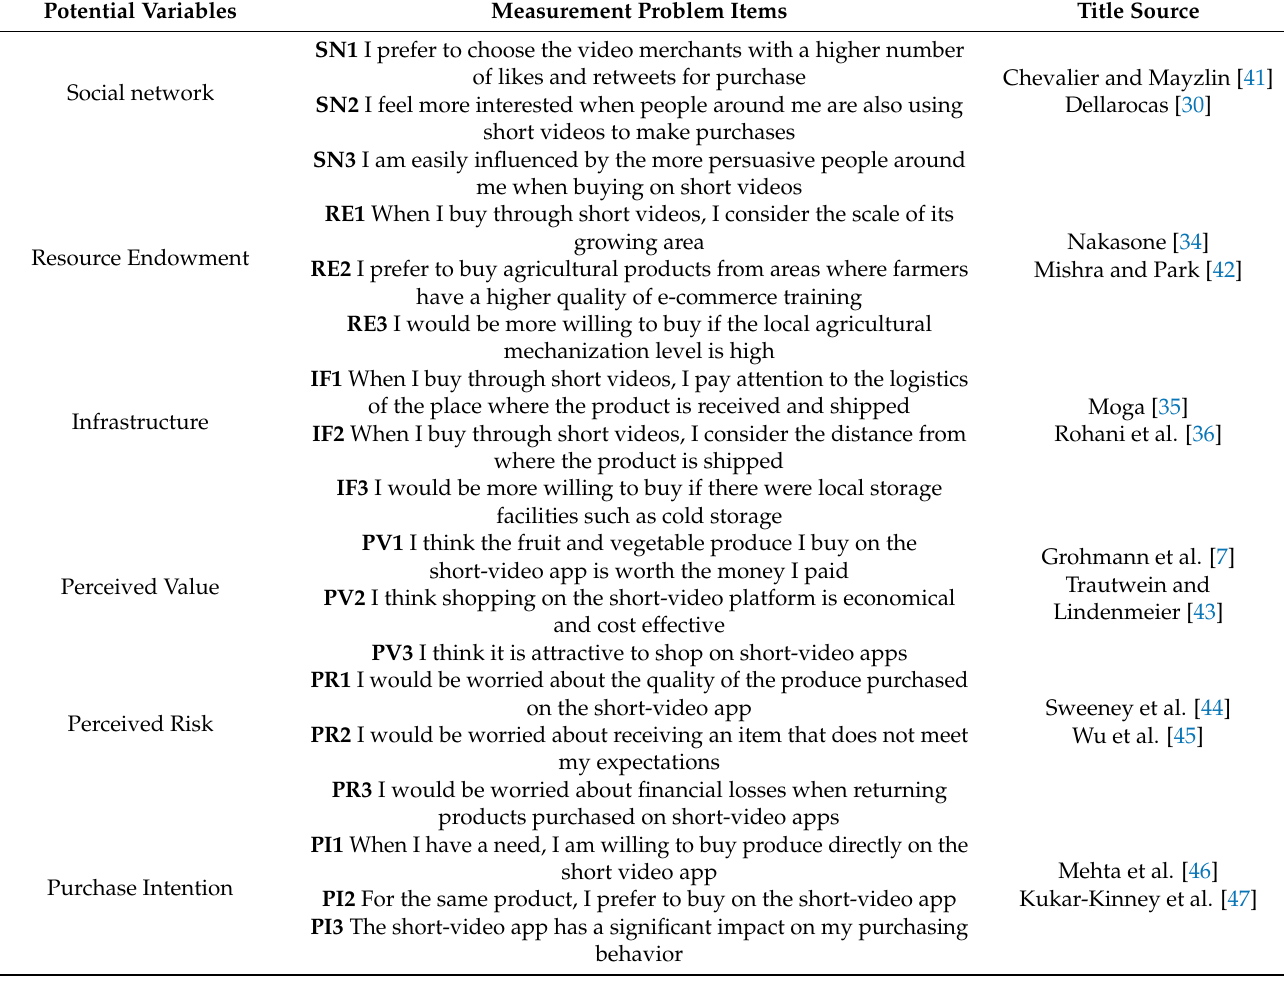
Table 1. Relevant variables and